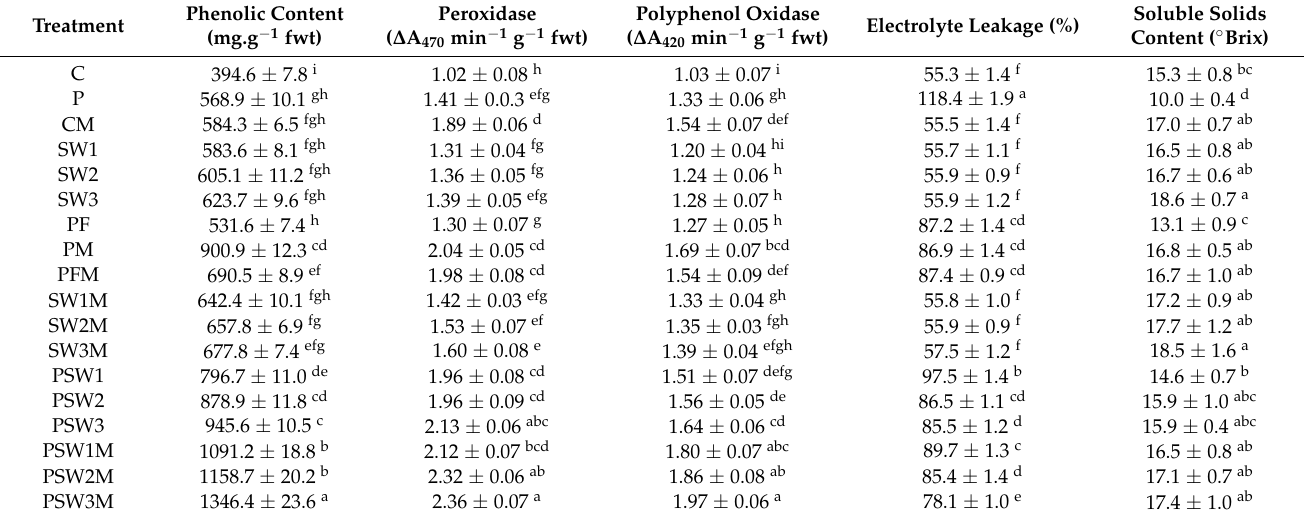
Table 5. Mean phenolic content, activity of antioxidant enzymes, electrolyte leakage, and total soluble solids of pea roots (cv. Master-B) infected with Rhizoctonia root rot in response to treatment with the seaweed extract and/or colonization with arbuscular mycorrhizal fungi at 20 days post-inoculation